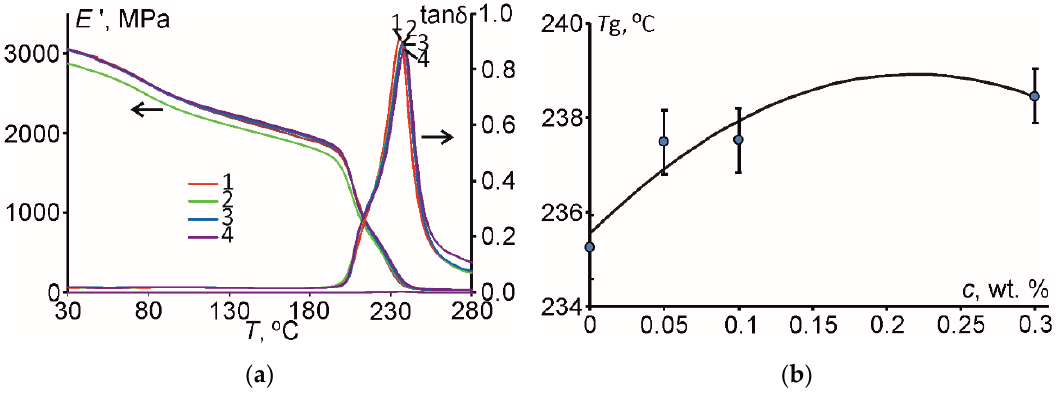
Figure 4. ( a ) Storage modulus ( E ’) and loss factor (tan δ ) of the epoxy ( 1 ) and epoxy filled with 0.05 wt. % of CNT ( 2 ), 0.1 wt. % of HN ( 3 ), and 0.3 wt. % of CNF ( 4 ) vs. temperature before the hydrothermal aging; ( b ) glass transition temperature ( T g ) vs. filler weight fraction for the materials studied (dots—experimental data, line—polynomial approximation).